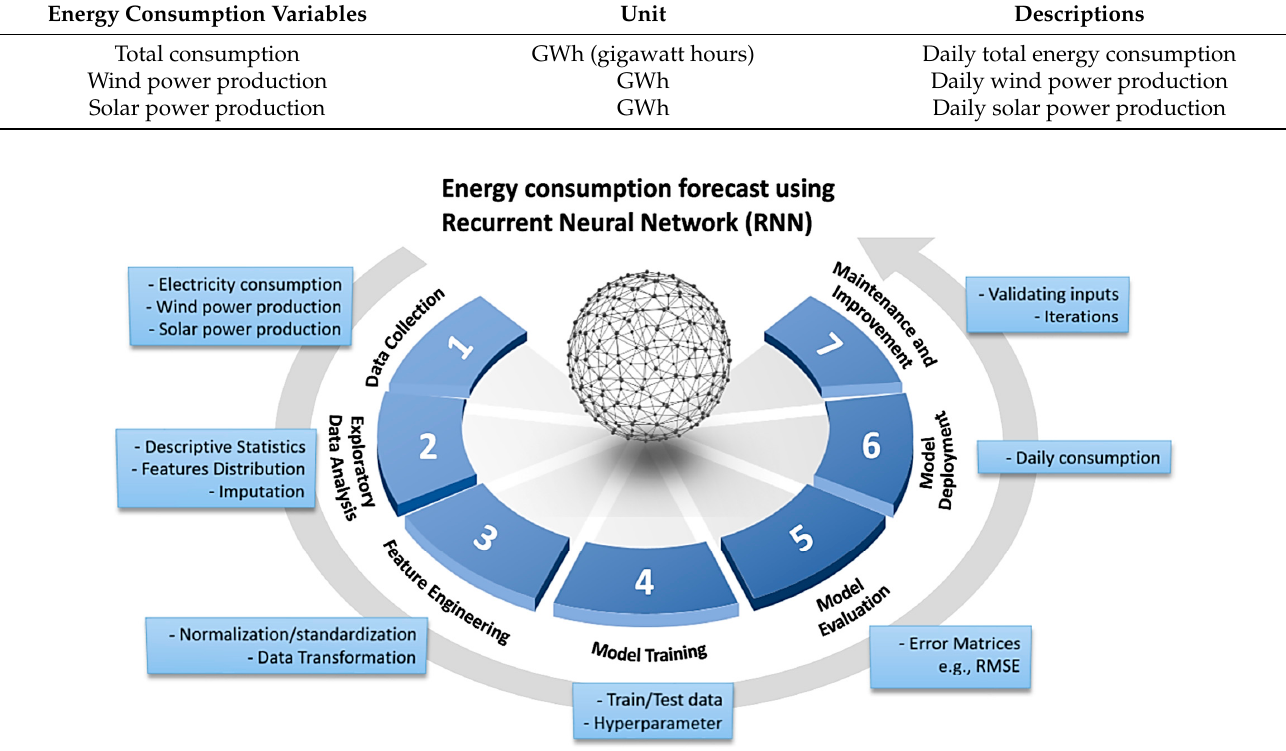
Figure 1. Entire pipeline of RNN-based prediction.